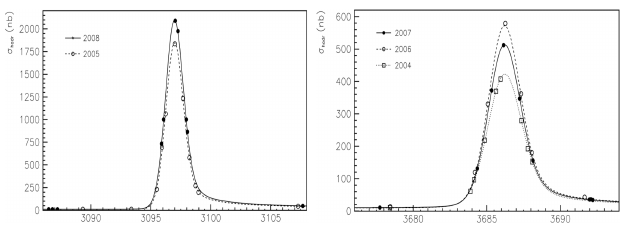
Figure 2. The measured hadronic cross section without the correction of the detection e ffi ciency as a function of the CM energy for J /ψ scans (Left) and ψ (2 S ) scans (Right) [22]. The lines present the fit results.